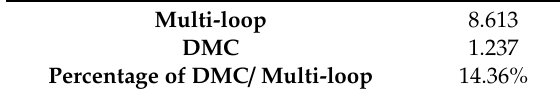
Table 4. Squared error sum comparison of AFR in 1000 MW plant.